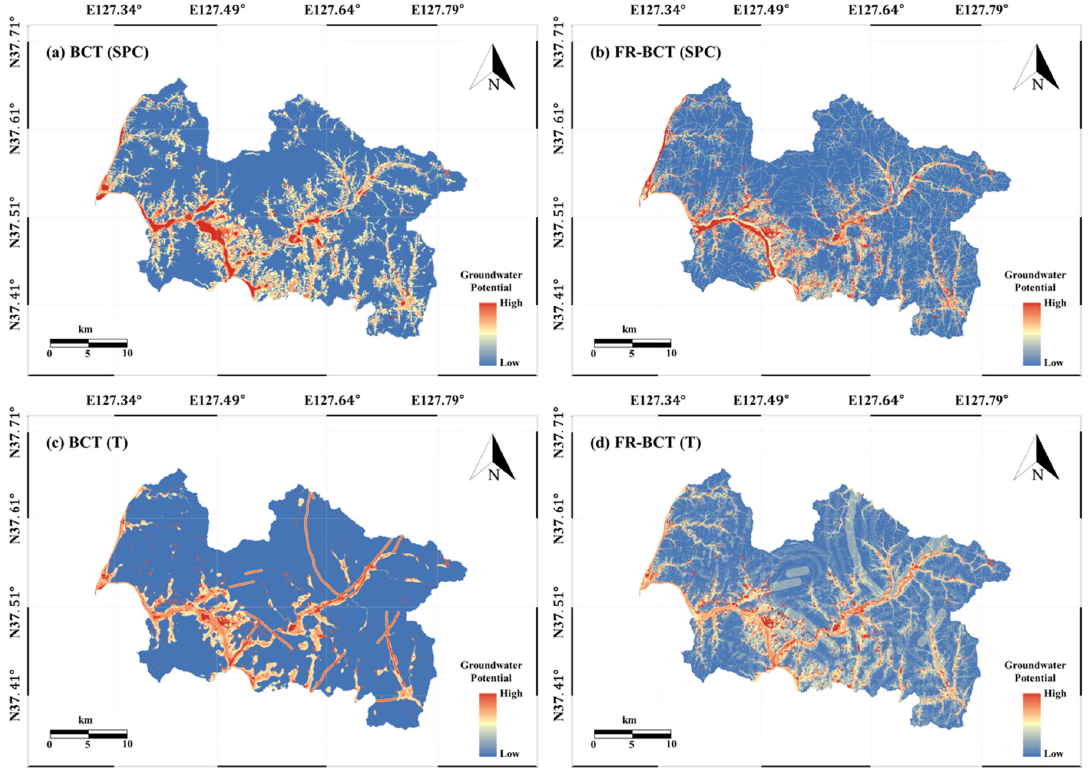
Figure 6. Groundwater potential maps based on ( a ) boosted classification tree (BCT) and ( b ) frequency ratio (FR)-BCT models with specific capacity (SPC) data, and ( c ) BCT and ( d ) FR-BCT models with transmissivity (T) data.